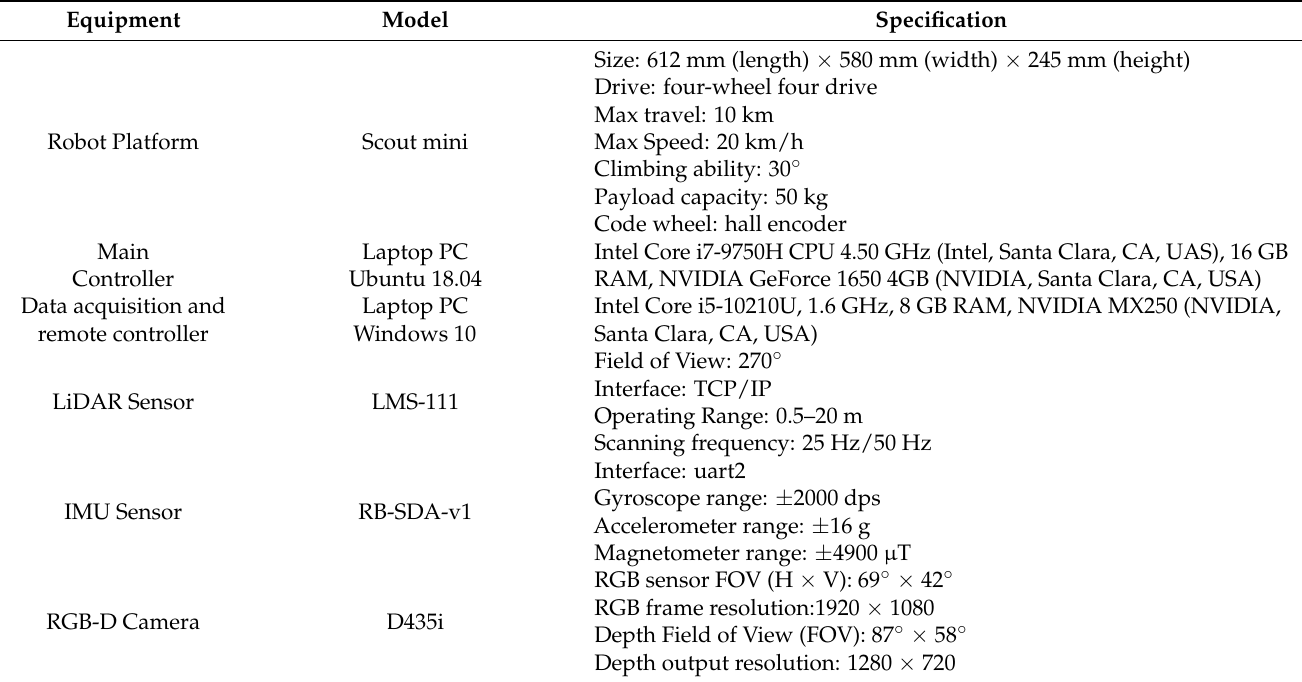
Table 1. Specifications of sensors and robot platform used in this